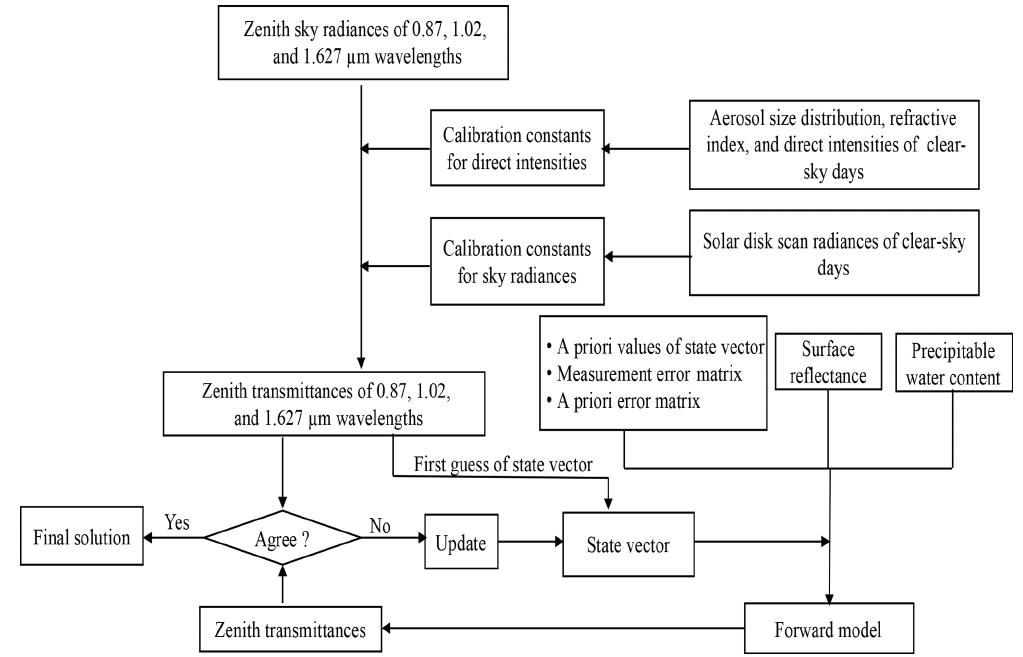
Figure 1. Schematic of the study